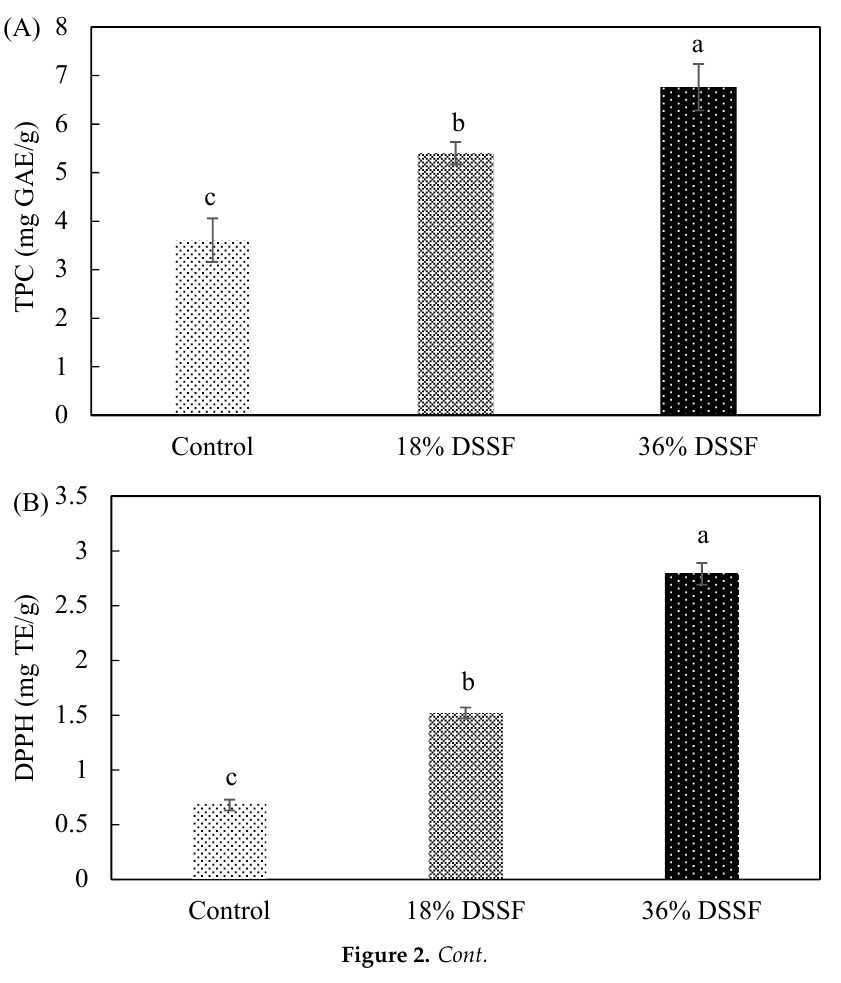
Figure 2. Total phenolic content (TPC) ( A ), DPPH ( B ), and CUPRAC ( C ) values of control and defatted sunflower seed flour (DSSF) biscuits at 18% and 36% inclusion. Data are expressed as means ± SD ( n = 3). Bars with same letter are not significantly different at p < 0.05. 3.4. Effect of Defatted Sunflower Seed Flour on Sensory Properties of Biscuits The trained panel detected significant differences in eight descriptors of the 29 rated (Figure 3 and Table 4). In terms of appearance, panellists scored DSSF biscuits as more brown than the control, which is in accordance with the instrumental colour test results. Another appearance descriptor that differed was crumb aeration, with the 18% DSSF and control biscuits showing similar crumb aeration,